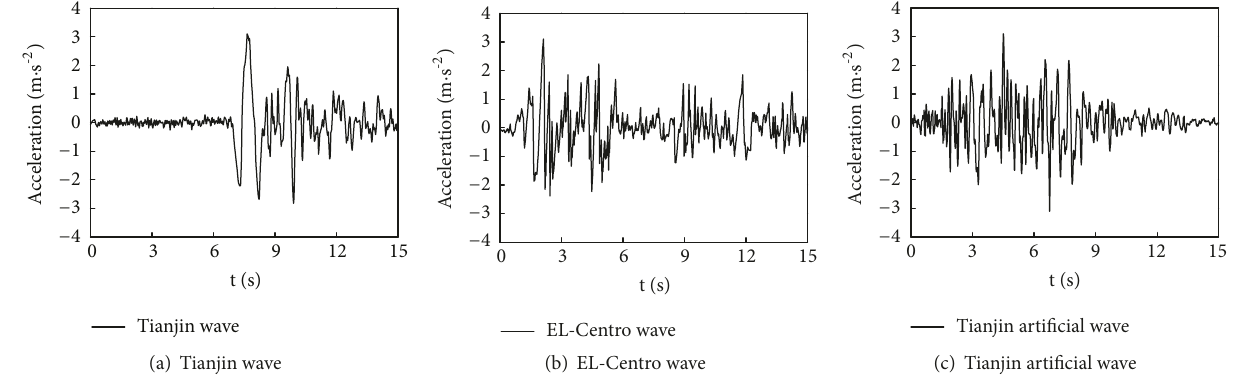
Figure 21: Acceleration time history curve of seismic wave.